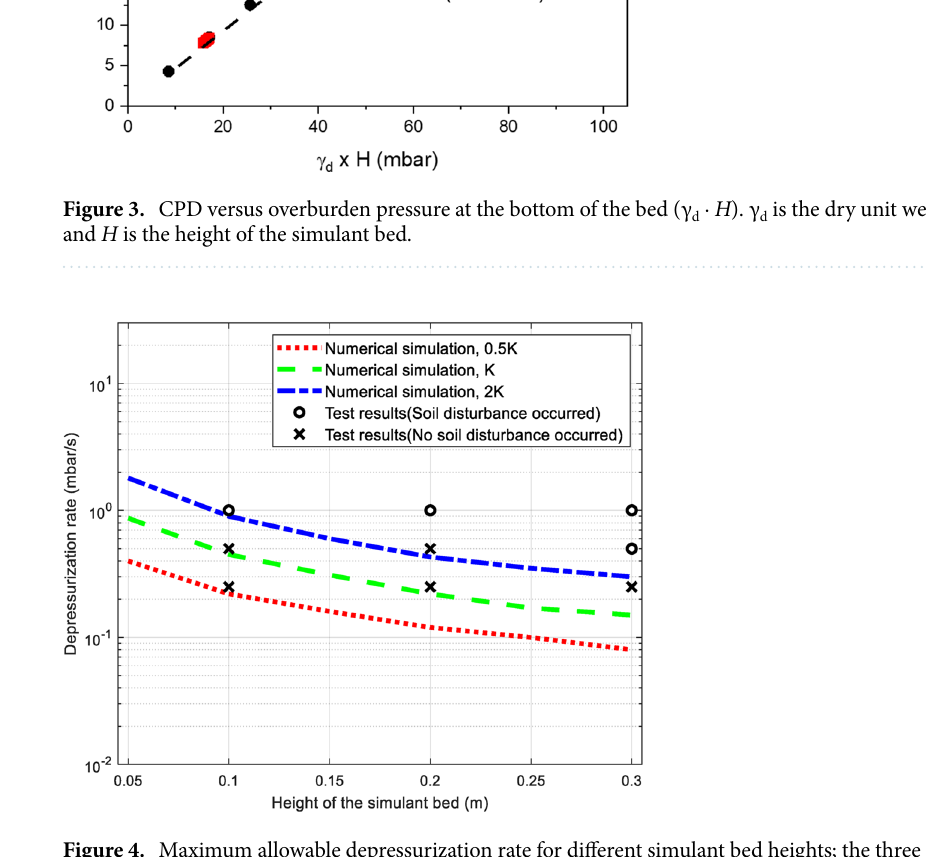
Figure 4. Maximum allowable depressurization rate for different simulant bed heights; the three curves correspond to different intrinsic permeabilities of 0.5 K , K , and 2 K . K = 2.55 × 10 −13 m 2